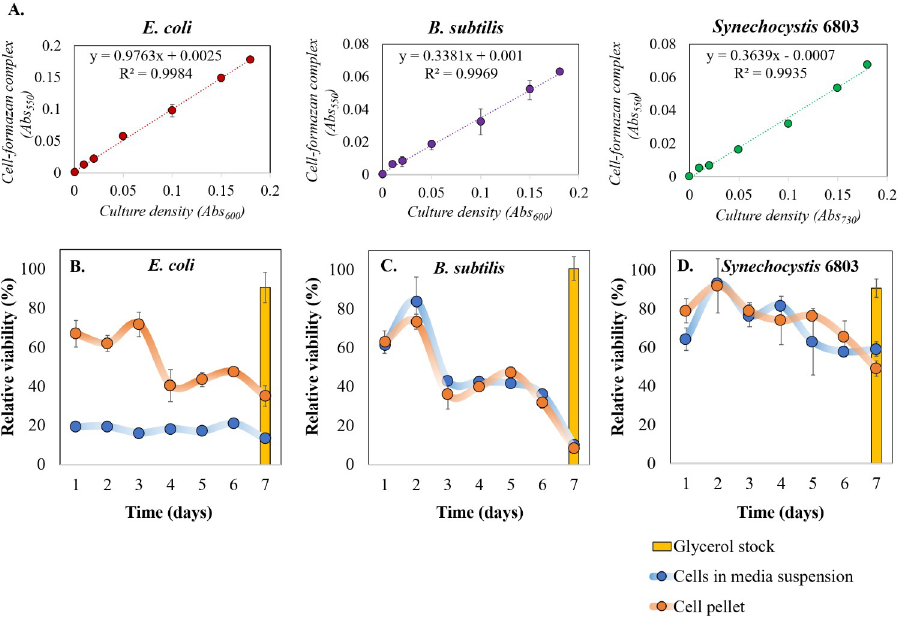
Fig 2. Impact of storing cells at ultra-low temperature on cell viability. The cells stored at ULT over a period of 7 days were subjected to MTT assay. MTT assay is based on a simple principle of active dehydrogenase present in viable cells, whereby such active cells can convert MTT to MTT-formazan-cell complex (solubilized in DMSO), which has a λ max of 550 nm. This establishes direct correlation between cell viability and absorbance at 550 nm. We hereby present MTT assay standard curves for bacteria with different cell densities (measured by Abs 600 or Abs 730 ) (A), and relative (%) viability plots (with respect to that of freshly harvested cells) for E . coli (B), B . subtilis (C), Synechocystis 6803 (D) with (blue) and without (orange) the culture media. Relative viabilities were also compared with their glycerol stocks (bars in the plots) which had almost 100% viability. Data are shown as mean ± S.D, n =